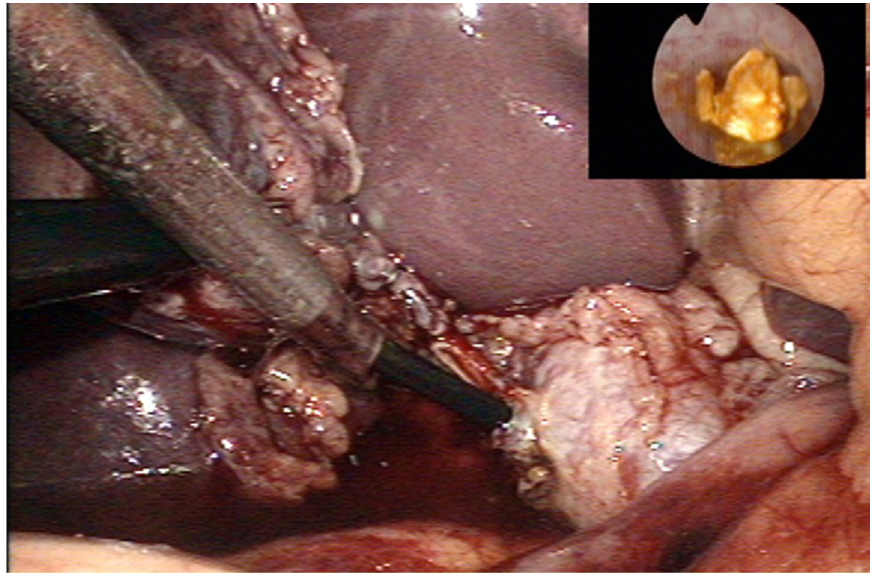
Figure 2. Intraoperative finding—Transcystic choledohoscopy with visualisation of the stone.